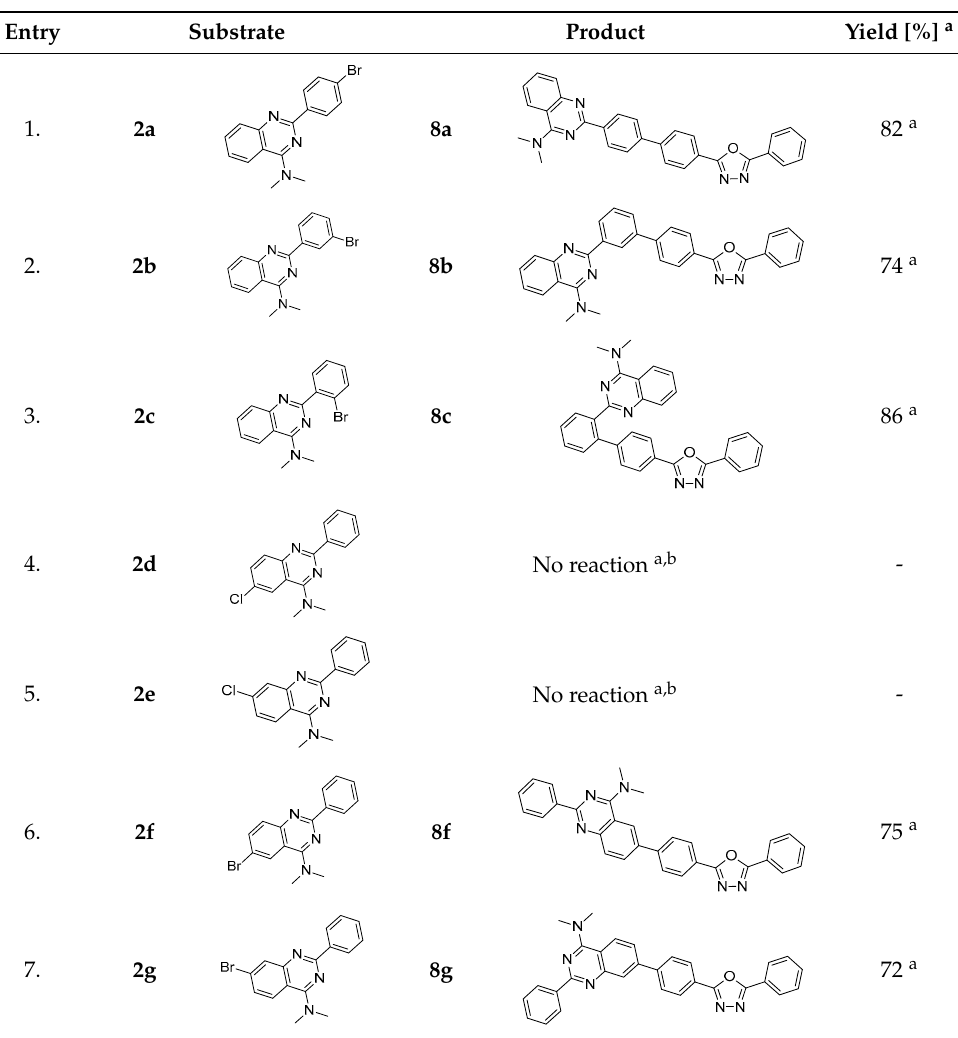
Table 2. Synthesis of unsymmetrical quinazolinylphenyl-1,3,4-oxadiazole derivatives ( 8a-c, 8f-g ) using Suzuki cross-coupling reactions.